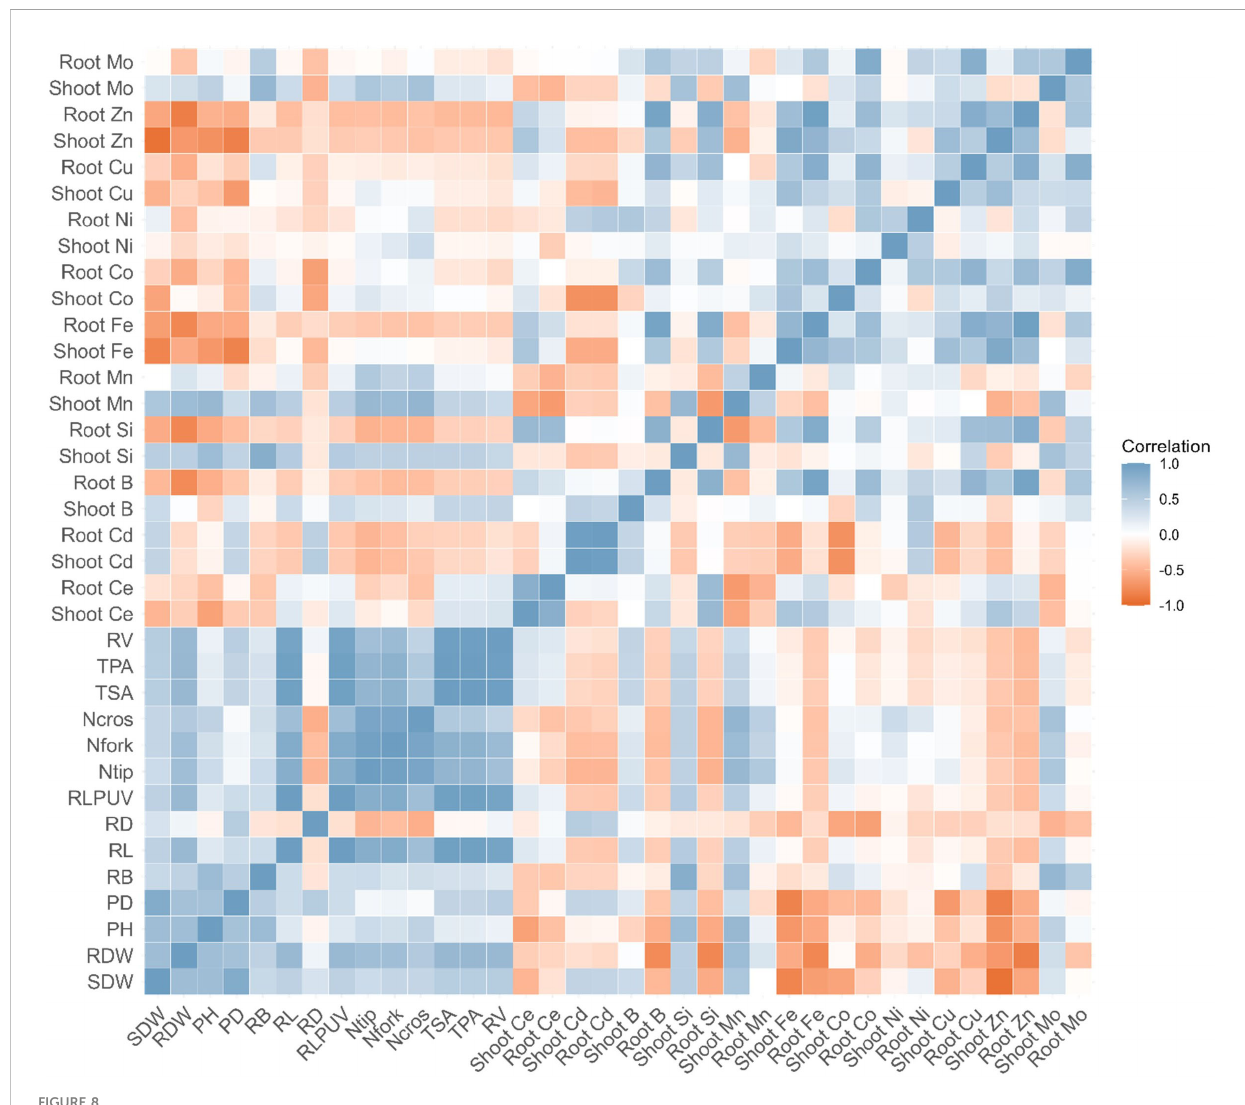
FIGURE 8 The Correlation tree map among acquired parameters of maize seedling ( n = 12) as, shoot dry weight (SDW), root dry weight (RDW), plant height (PH), plant diameter (PD), root barrier length (RB), total root length (RL), average root diameter (RD), root length per unit volume (RLPUV), number of root tips (Ntip), number of root forks (Nfork), number of root crosses (Neros), total root surface area (TSA), total root projected area (TPA), total root volume (TV). shoot and root elemental contents (Ce, Cd, B, Si, Mn, Fe, Co, Ni, Cu, Zn,